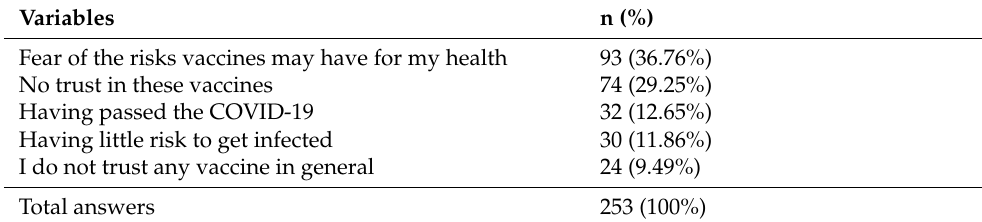
Table 2. Reasons why respondents considered not getting vaccinated with a booster dose.